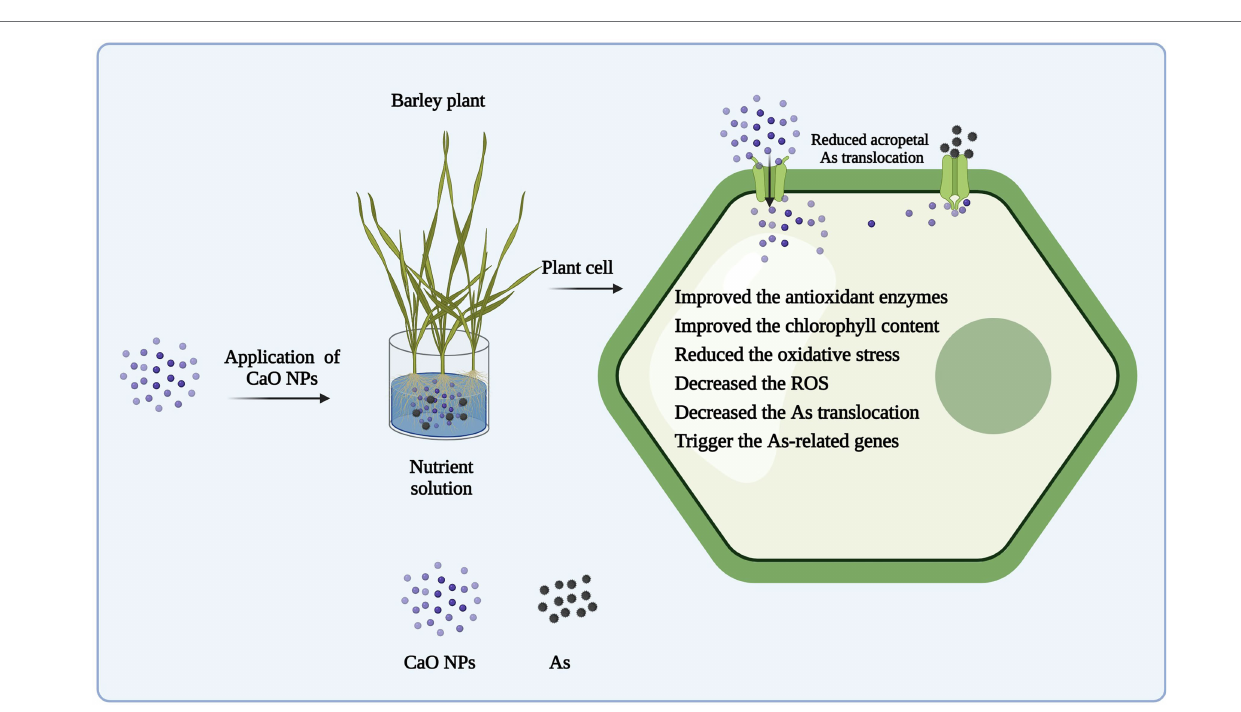
FIGURE 8 | Working model showing how CaO NPs supplementation reduce As-induced phytotoxicities in barley seedlings. Initially, CaO NPs, after entering plant body, activate enzymatic antioxidants (i.e., SOD, POD, and CAT), which in turn help barley seedlings to manage metal-induced oxidative stress. Further, CaO NPs application supports plant growth by improving Ca 2+ ions homeostasis and photosynthesis. In addition, CaO NPs reduce uptake, mobilization, and acropetal translocation of As by decreasing the transcript abundance of As transporting genes ( HvPHTs ), which ultimately helps plant to reprogram its normal physiological and developmental